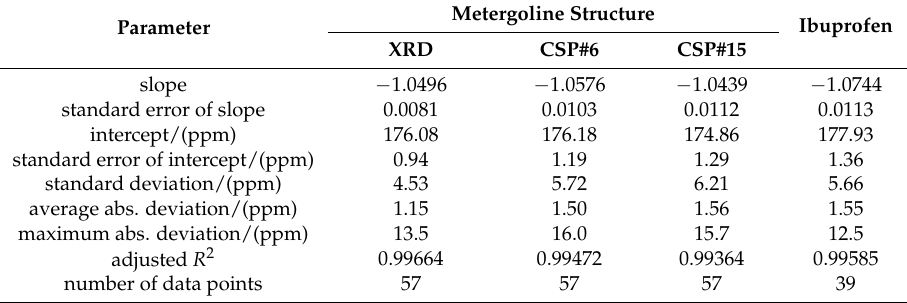
Table 2. Statistical evaluation of the agreement between the principal elements of the GIPAW-RPBE 13 C chemical shielding tensors obtained for three structural models of metergoline, and the principal elements of the 13 C chemical shift tensors measured for polymorph I. The results for ibuprofen are included for comparison purposes.